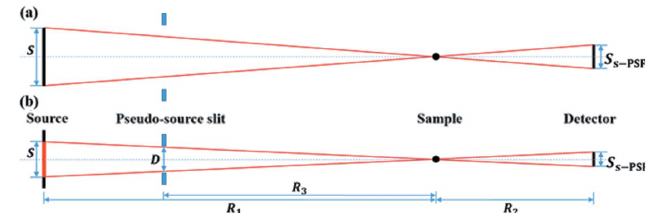
Figure 2 Principle diagram for calculating the size of the source PSF. ( a ) When the white-beam slit is fully opened, the intensity of any point on the sample comes from the contribution of each point on the entire source (black). In this case, the entire source size is the effective size. ( b ) When the slit size becomes smaller, the intensity comes from the contribution of each point on the effective source